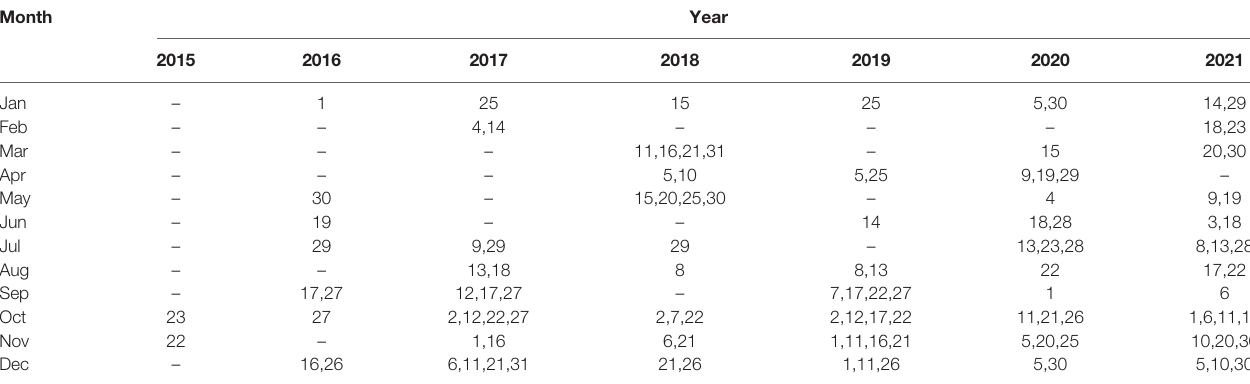
TABLE 3 | Dates of the cloud-limited Sentinel-2 scenes retrieved and analyzed in this